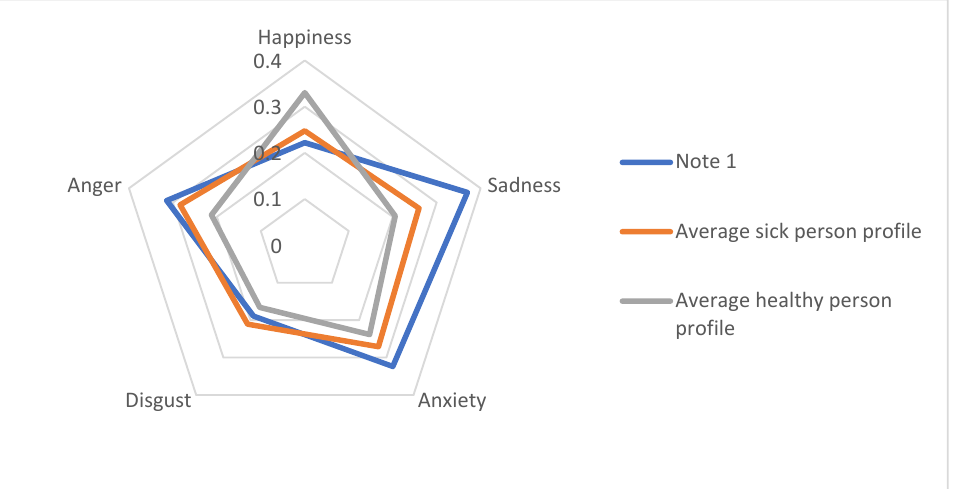
Figure 7. Comparison of the intensity of emotions present in the first note with the profiles of a healthy person and a person suffering from anorexia nervosa (the values of the intensity of emotions range from 0 to 1, where 0 means that there is no emotion in the note, and 1 the maximum value of emotion in the note).